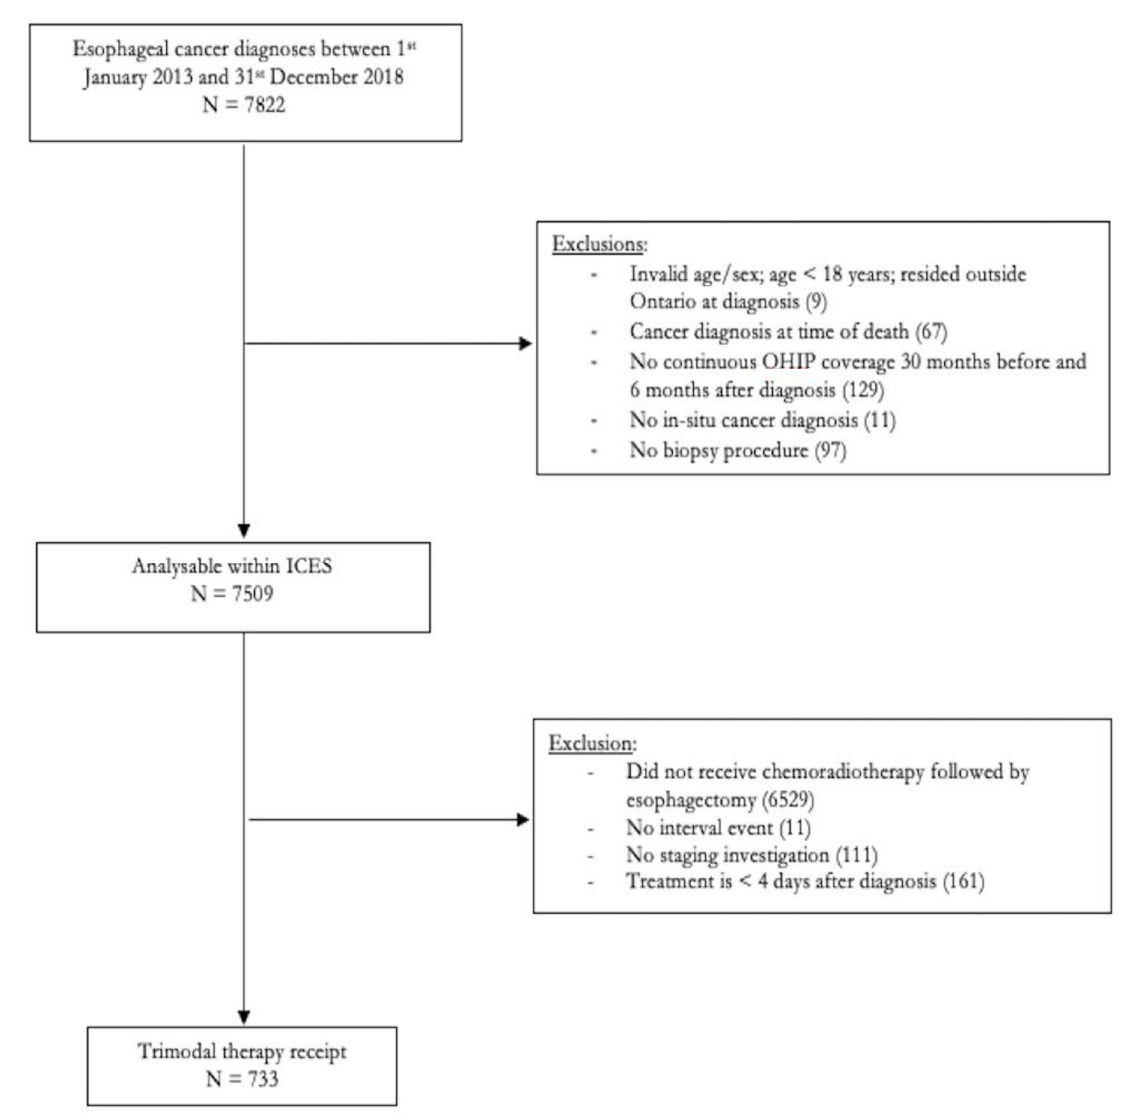
Figure 1. Cohort